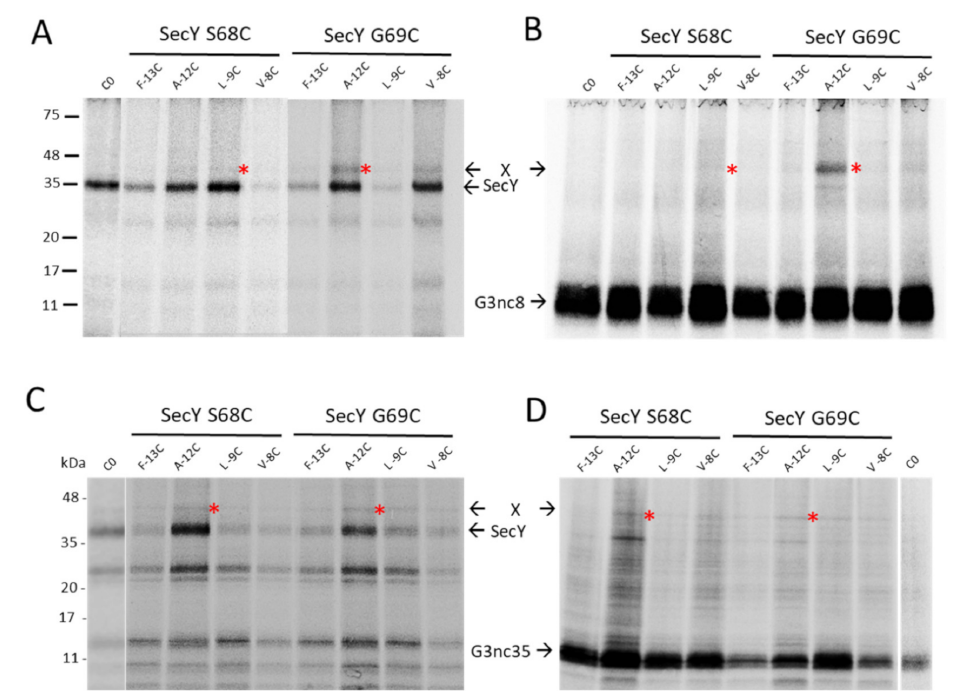
Figure 5. Ribosome-nascent chains (RNCs) of G3p contact SecY. The plasmids encoding G3nc8 ( A , B ) and G3nc35 ( C , D ) were coexpressed with plasmid-encoded SecYEG in E. coli MG1655-SecE. The G3ncs had single cysteine mutations at positions − 13, − 12, − 9 or − 8 in the signal sequence, and in SecY a single cysteine at position 68 or 69, respectively. The exponentially growing cells were induced with 1 mM IPTG for 10 min, pulse labelled with 35 S-methionine/cysteine for 2 min, treated with copper phenanthroline for 10 min and processed for immunoprecipitation with an antibody to the T7-tag recognizing SecY ( A , C ) or to the Flag-tag recognizing the G3nc ( B , D ). For a control, a plasmid expressing the cysteine-less SecY was analysed. The potential crosslink products are marked with red